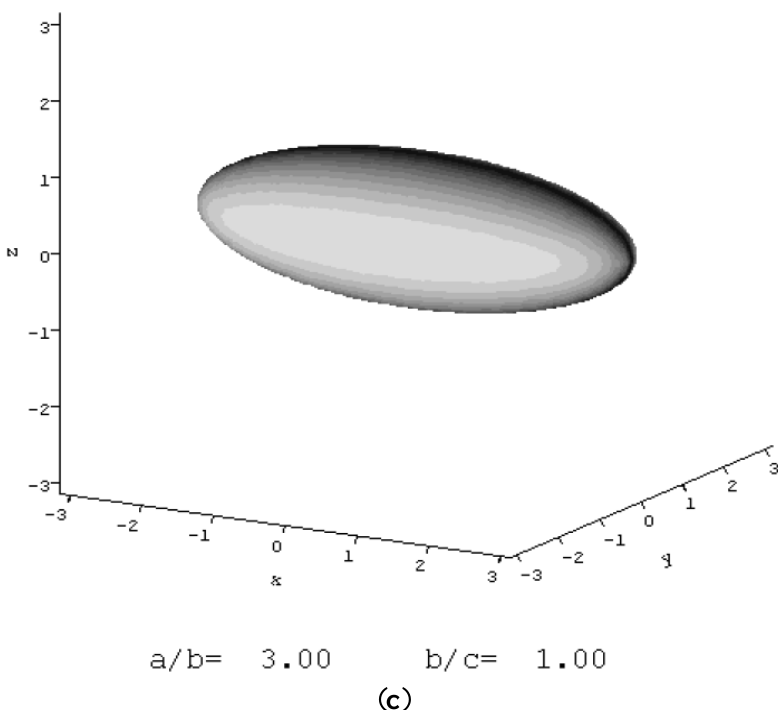
Figure 1. ( a ) Sedimentation coefficient distribution profiles, c (s) vs. s , for tetanus toxoid protein at different concentrations, showing mostly monomer with a smaller proportion of dimer not in reversible equilibrium; ( b ) Corresponding molecular weight distribution plots c(M) vs. M ; ( c ) Low resolution structure of tetanus toxoid protein using the simple ellipsoid modelling routine ELLIPS1 showing clearly its extended form of axial ratio ~3:1. Reproduced from reference 18 with permission from